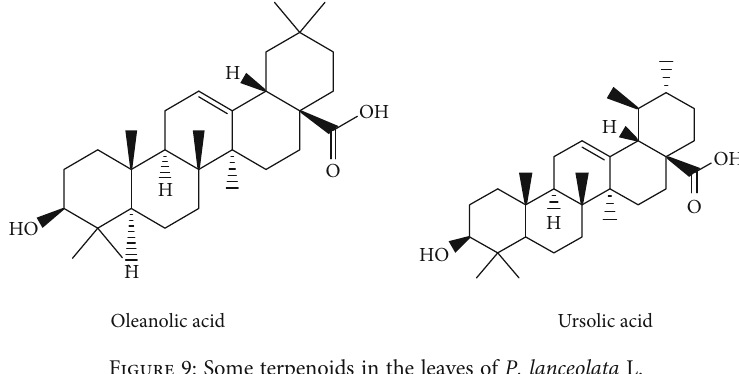
Figure 9: Some terpenoids in the leaves of P. lanceolata L.